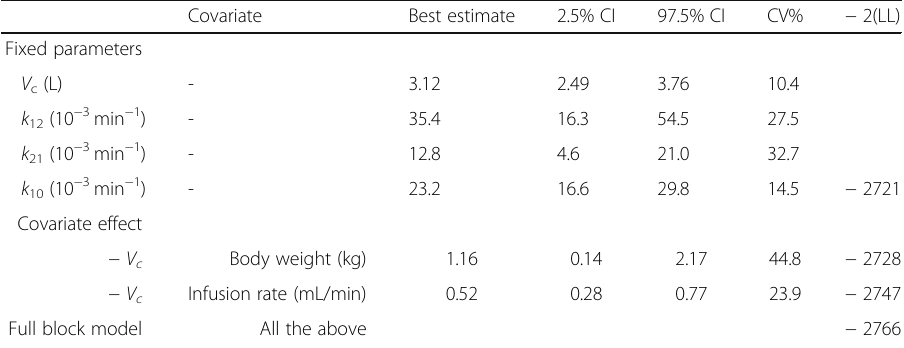
The right column shows how the log likelihood of the model gradually improves (decreases) when a new covariate is added. A reduction by 3.6 points is statistically significant by P < 0.05 CI confidence interval, CV between-subject coefficient of variation, LL log likelihood for the